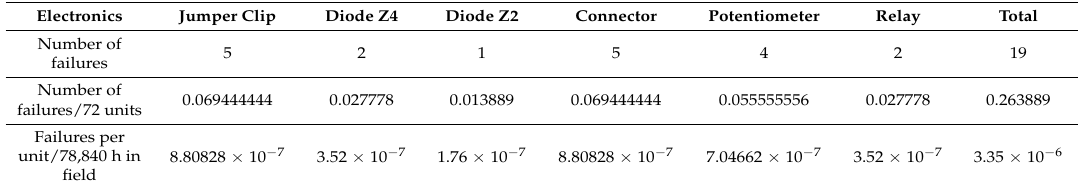
Table 1. Flow Measurement Sensor Electronics Failures of 72 Fielded